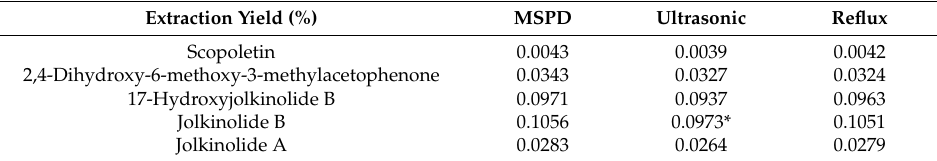
Table 6. Comparison the extraction yields of Scopoletin, 2,4-Dihydroxy-6-methoxy-3-methylacetophenone, 17-Hydroxyjolkinolide B, Jolkinolide B, and Jolkinolide A in Euphorbia fischeriana by MSPD, ultrasonic and reflux extraction